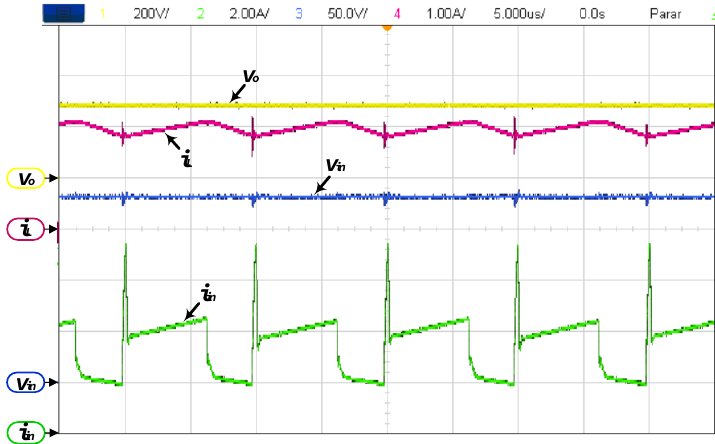
Figure 11. v o (200 V/div); i L (1 A/div); v in (50 V/div); i in (2 A/div); time: 5 µ s/div. The dynamic responses of V o , i L , and i D , during a load variation, are shown in 1 Figure 12. Initially, at t = 400 ms the load decrease from 600 W to 300 W, and then, at t = 1250 ms, the load is increased from 300 W to 600 W. It can be verified an output-voltage overshoot lower than 6% of the rated voltage.